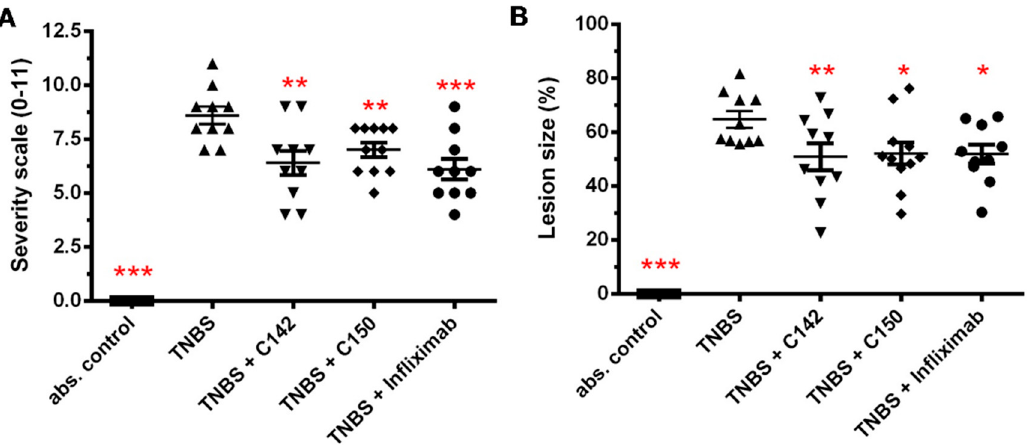
Figure 5. ( A ) Severity scale and ( B ) lesion size of the inflamed colon preparations. Both C142 and C150 curcumin analogues exerted a significant decrease in the severity of colonic inflammation and lesion size. Severity scaling and the measurement of lesion size was performed as described in Section 4.5 of Materials and Methods. Results are shown as mean ± S.E.M.; n = 8–11; * p < 0.05, ** p < 0.01, *** p < 0.001 pair-wise comparison with TNBS-treated